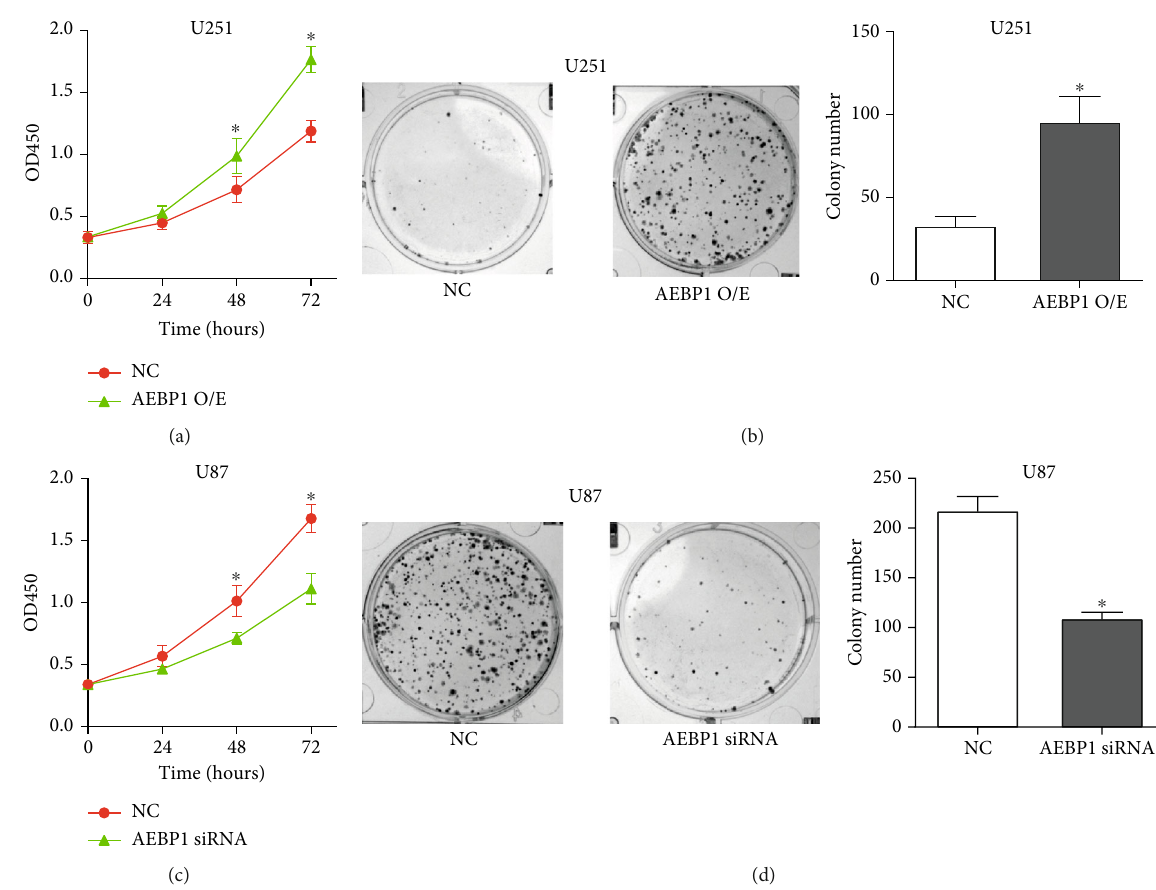
Figure 4: AEBP1 promoted GBM cell proliferation in vitro. The AEBP1 overexpression plasmid was transfected in U251 cells, and AEBP1 siRNA was transfected in U87 cells. Cell proliferation was assessed by the (a, c) CCK8 assay and (b, d) colony formation assay. N = 3 , ∗ P < 0 : 05